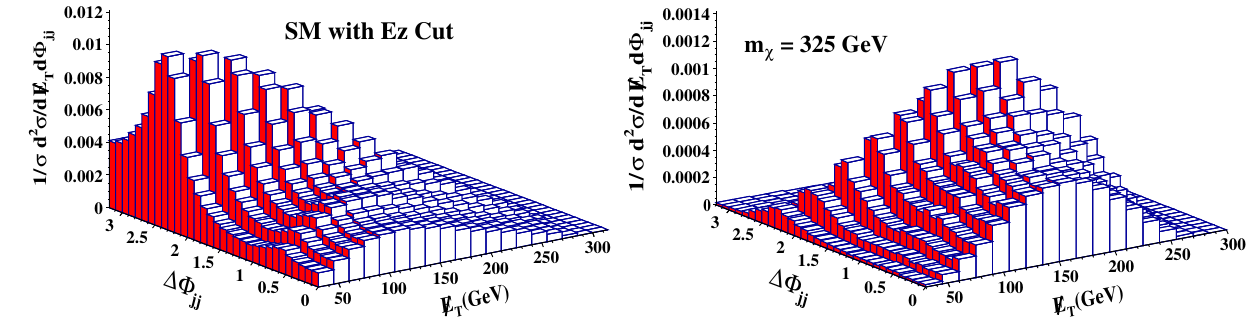
Fig. 6 Legoplotsshowingnormalised2-Ddifferentialcross-sectiondistributionw.r.t. (cid:15) E T and Δφ jj forthebackgroundandthe Z → j j associated